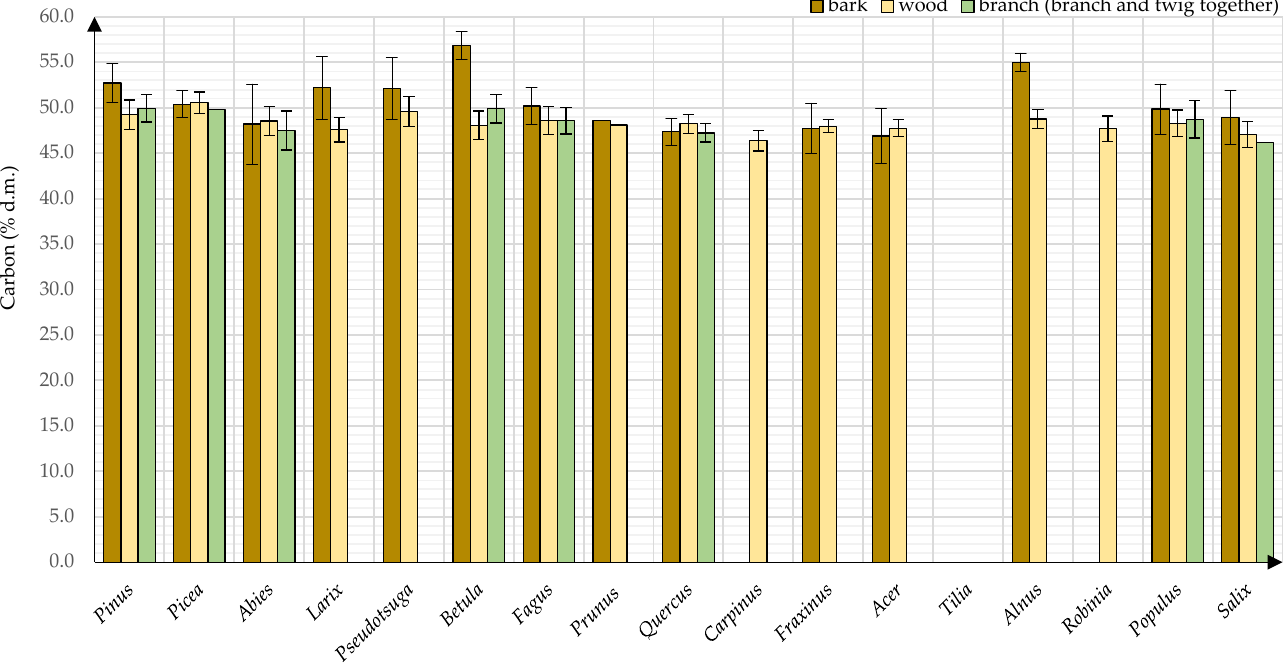
Figure 9. Average value and average deviation of the carbon content of organs of particular systematic genera trees.